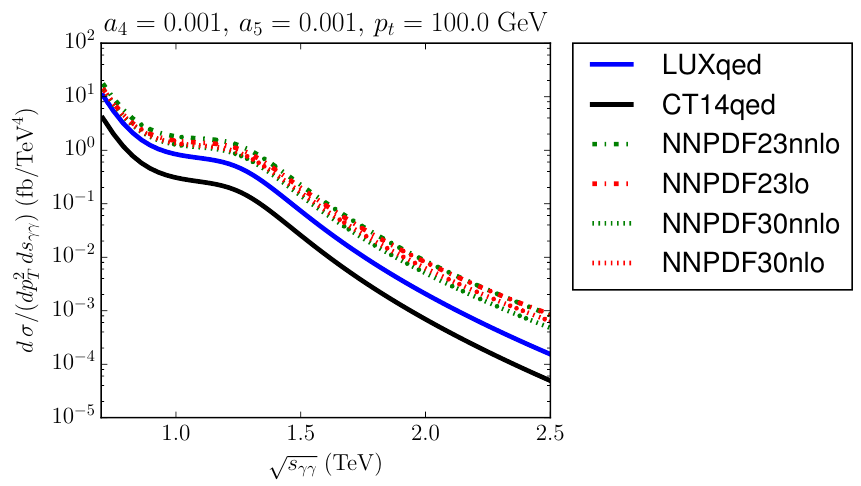
Figure 10 . Same as (cid:12)gure 9 but both protons dissociate in the deeply inelastic regime. The (e(cid:11)ective) PDF energy scale is (cid:22) 2 = s (cid:13)(cid:13)